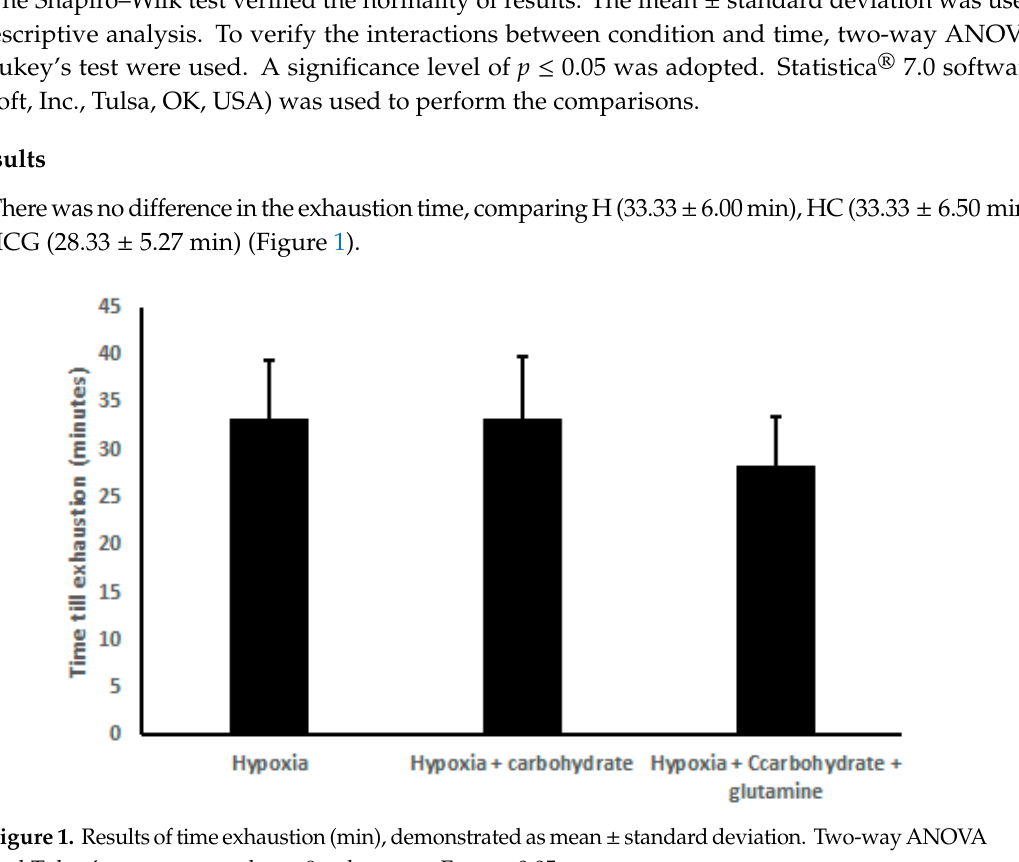
Figure 1. Resultsoftimeexhaustion(min), demonstratedasmean ± standarddeviation. Two-wayANOVA Figure 1. Results of time exhaustion (min), demonstrated as mean ± standard deviation. Two-way and Tukey’s test were used, n = 9 volunteers. For p < ANOVA and Tukey’s test were used, n = 9 volunteers. For p < 0.05.